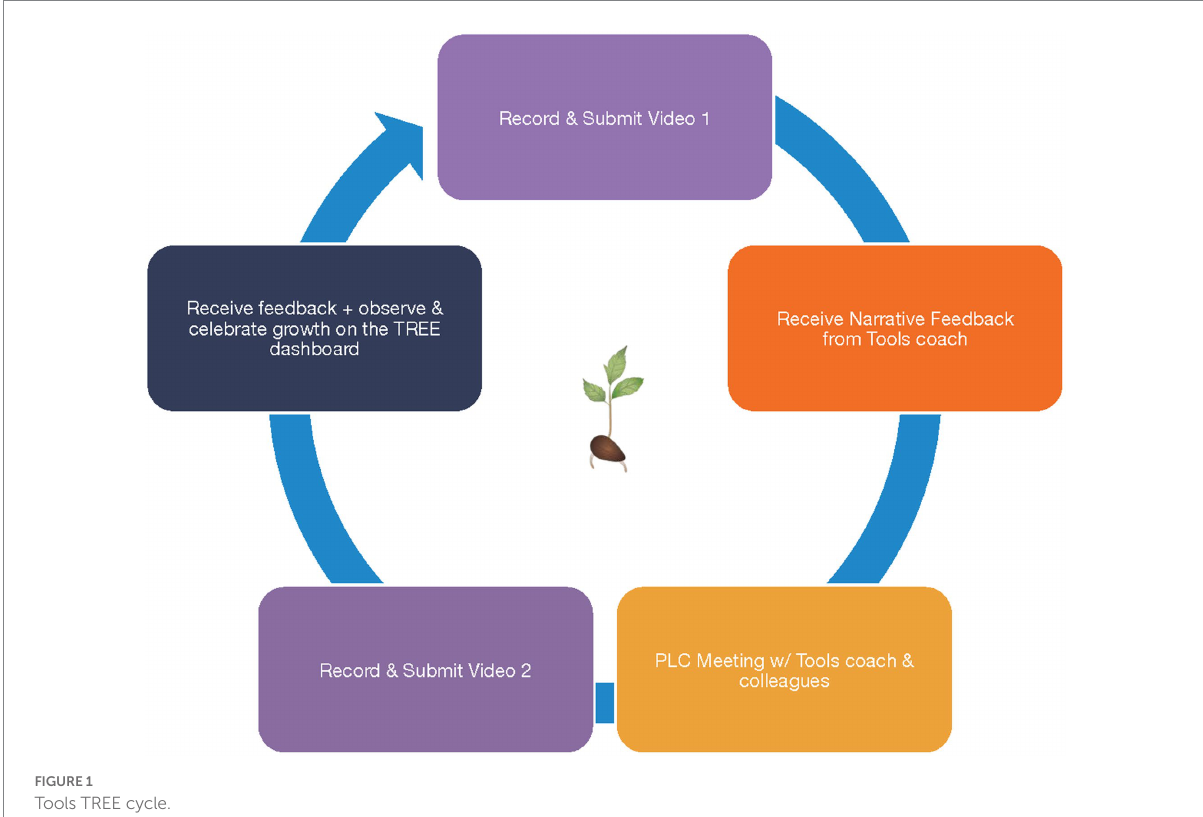
FIGURE 1 Tools TREE